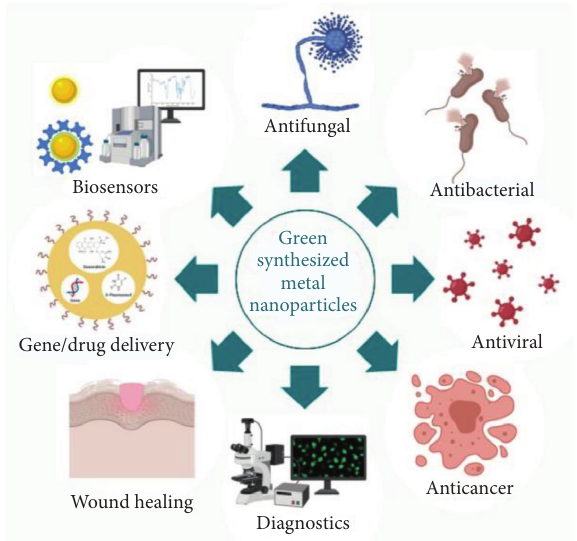
Figure 1: Green-synthesized metal nanoparticles’ medical appli- cations